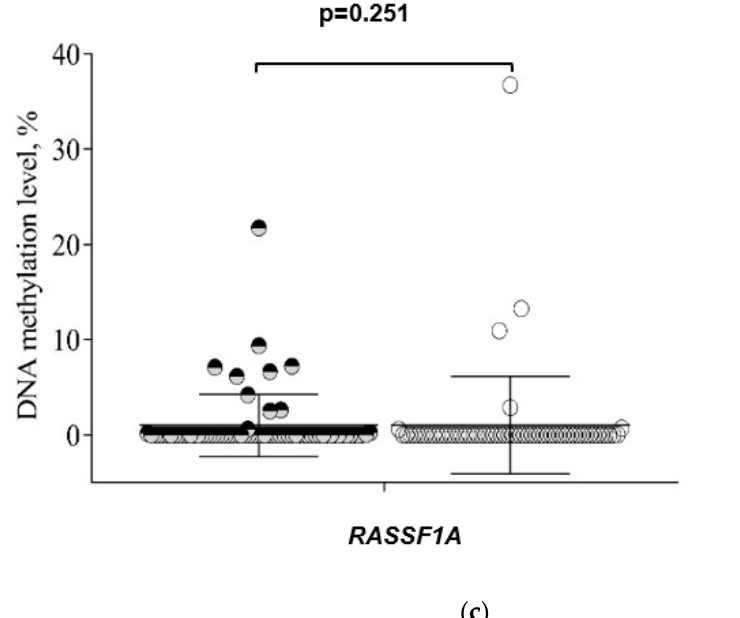
Figure 2. ( a ) The comparison of TSHR methylation level in papillary thyroid cancer (PTC) and healthy control (HC) patients. Analysis of the Mann–Whitney U test criterion was used to determine the differences in quantitative traits between the comparison groups. Data are expressed in whiskers plot for mean and standard deviation (SD). ( b ) The comparison of PTEN methylation level in papillary thyroid cancer (PTC) and healthy control (HC) patients. Analysis of the Mann–Whitney U test criterion was used to determine the differences in quantitative traits between the comparison groups. Data are expressed in whisker plots for mean and standard deviation (SD). ( c ) The comparison of RASSF1A methylation level in papillary thyroid cancer (PTC) and healthy control (HC) patients. Analysis of the Mann–Whitney U test criterion was used to determine the differences in quantitative traits between the comparison groups. Data are expressed in whiskers plot for mean and standard deviation